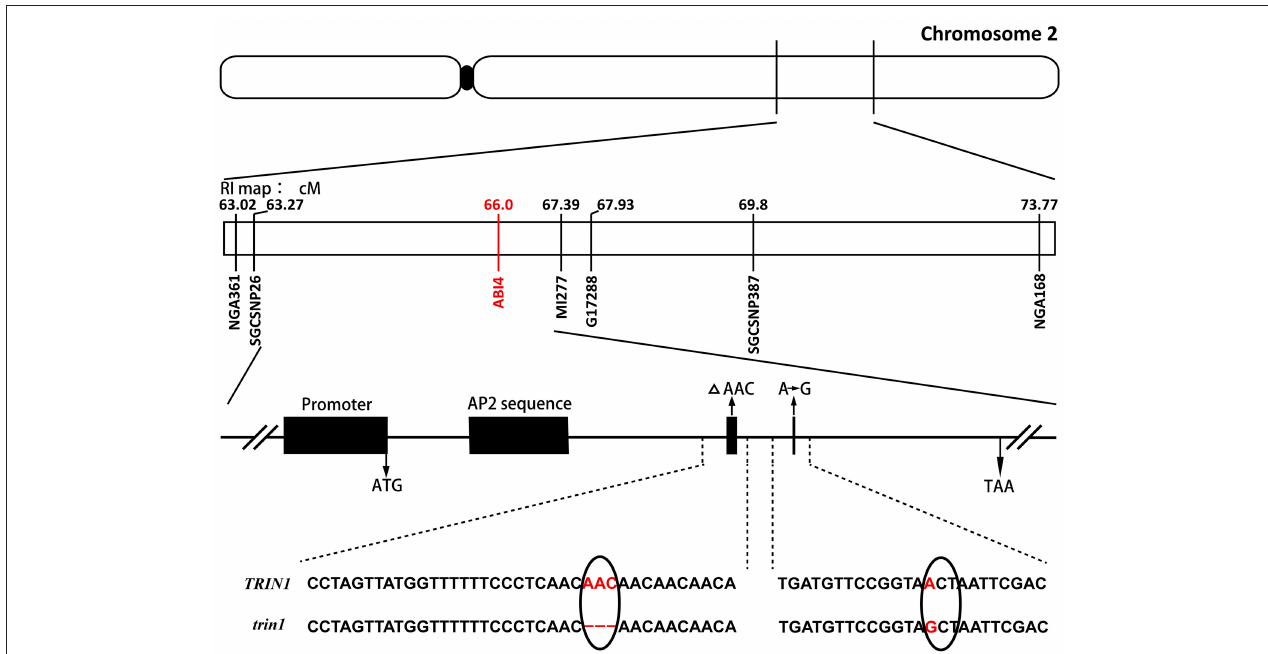
FIGURE 2 | Fine mapping of TRIN1 on chromosome 2. Sequence analysis of trin1 shows a 3-bp (AAC) deletion (as indicated by a 1 ) at positions 566–568 in the coding sequence that leads to deletion of the amino acid asparagine. Furthermore, a point mutation changing the first base of codon 229 of trin1 from A to G was identified (marked in red); it results in the substitution of threonine (ACT) with an alanine (GCT). The black solid oval represents the centromere.